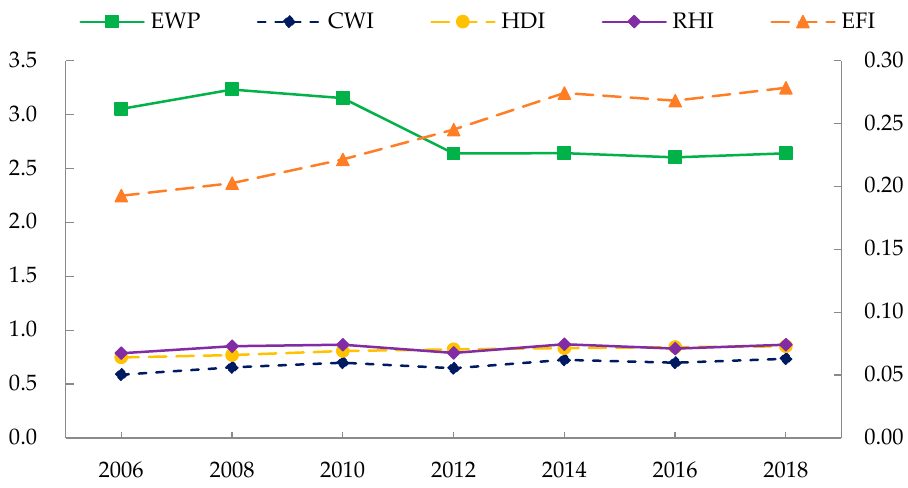
Figure 1. Temporal evolutionary trends of EWP and its components in China. Figure 2 reflects the time-series evolution trend of EWP in the eight economic regions of China from 2006 to 2018. Among the eight economic regions, only the northern coastal region, the eastern coastal region, and the southwest region experienced an increase in EWP, which further reflected the trend of lower EWP in China as a whole. The middle Yangtze River region and the southwest region benefited from low ecological consumption and improved residents’ happiness. Their EWP far exceeded the national average, with annual average values of 3.495 and 3.489, respectively. However, the northwest region, the middle Yellow River region, and the northeast region had annual average values of only 2.223, 2.098, and 2.066, respectively, due to the damage to the ecological environment caused by crude development methods. The EWP of the northern, eastern, and southern coastal regions were close to the national average, with annual averages of 3.018, 2.826, and 2.823, respectively. The EWP of the northern coastal region increased dramatically after 2012 from 2.631 to 3.300 in 2018, with an average annual growth rate of 1.906%, thanks to Beijing’s progress in improving human well-being and ecological governance.